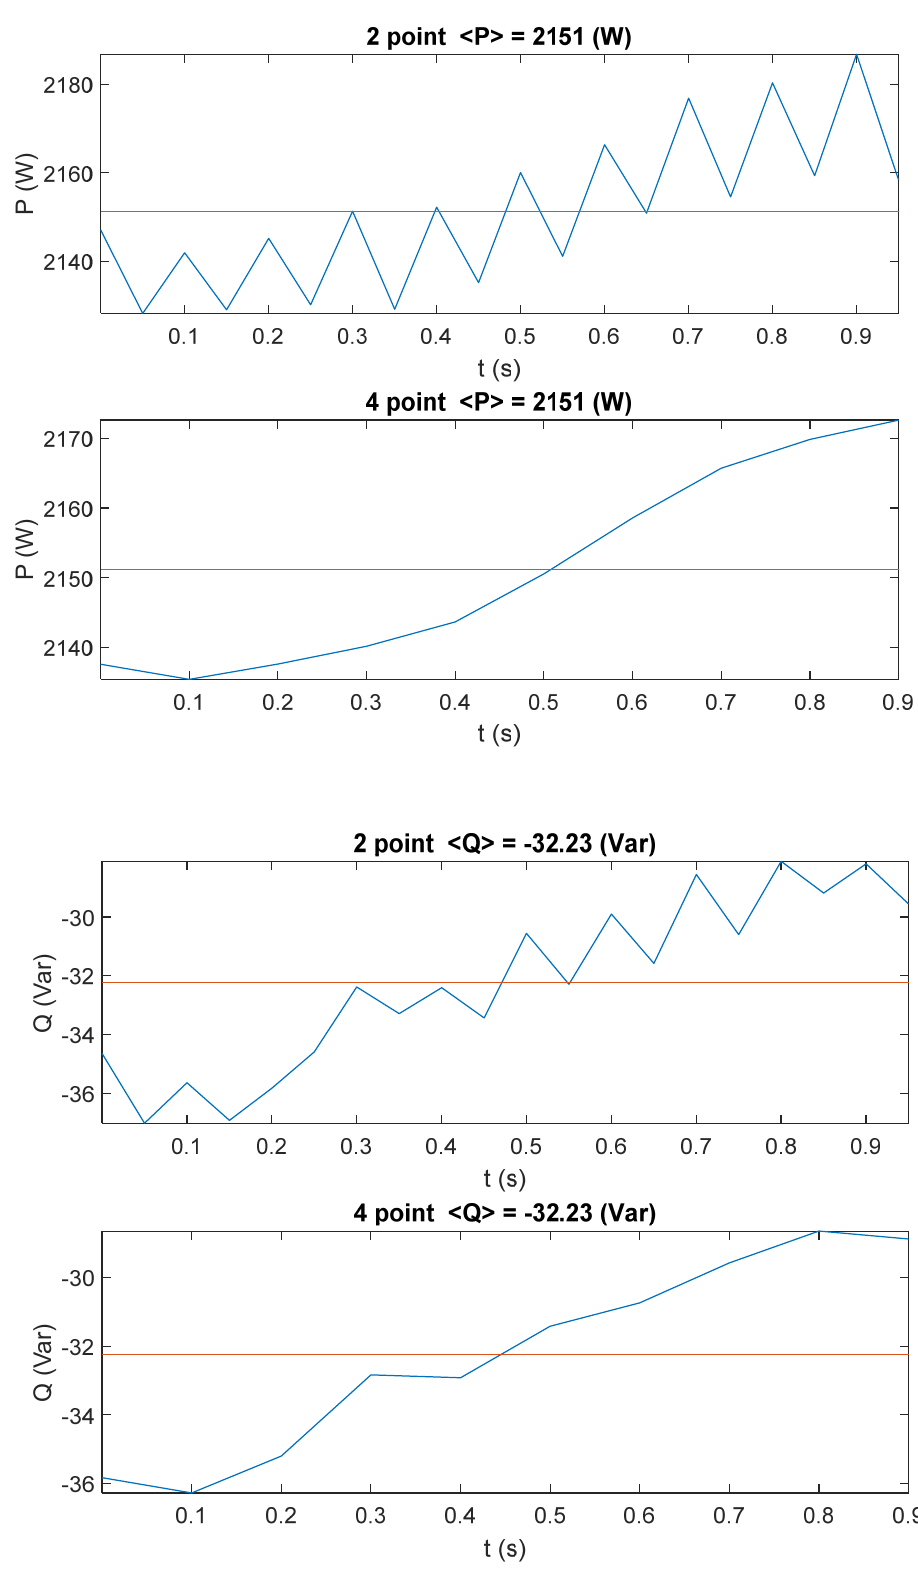
Figure 7. Two-point vs. four-point measurement method of power (before correction).